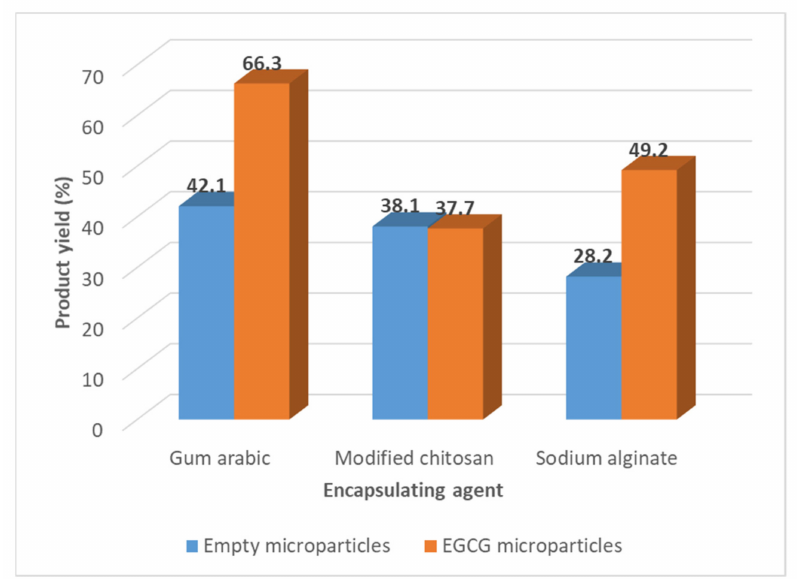
Figure 1. Values of the product yield of the spray drying process obtained in the preparation of different types of EGCG microparticles.